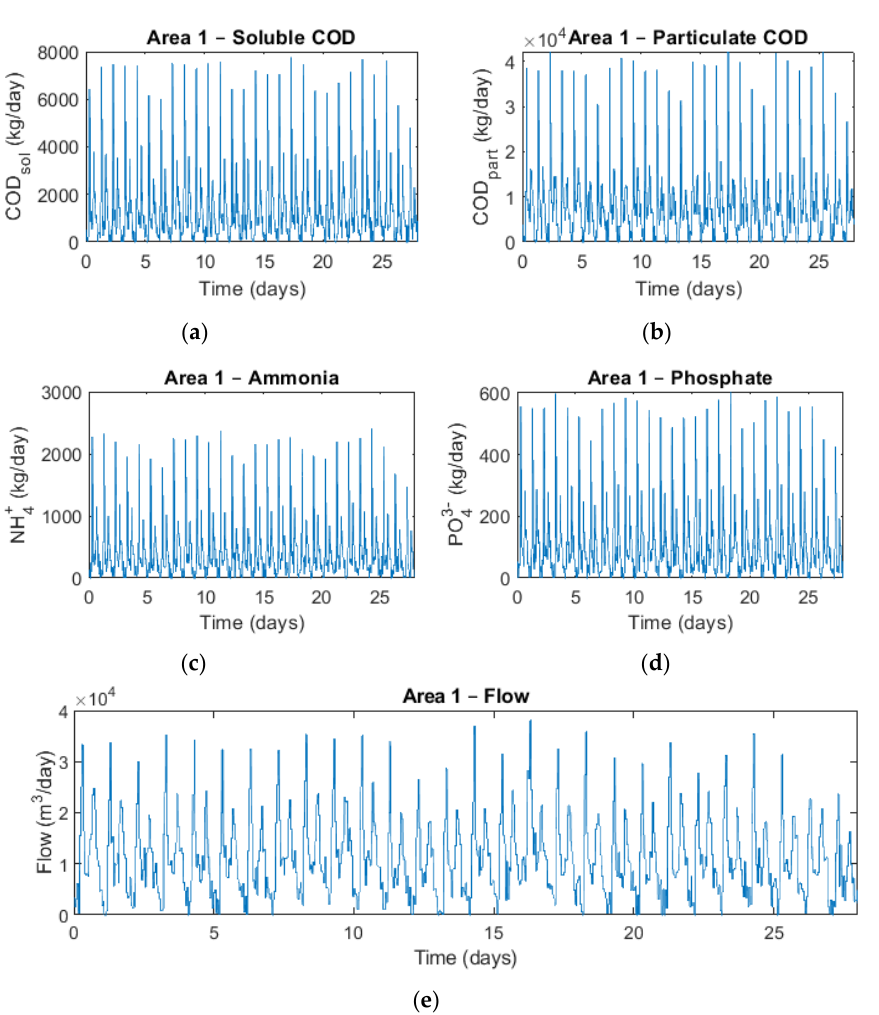
Figure 2. The influent corresponding to the 1st collection area: ( a ) soluble COD; ( b ) particulate COD; ( c ) ammonia; ( d ) phosphate; ( e ) flow of the 1st collection area. Table 4. Influent medium loads as